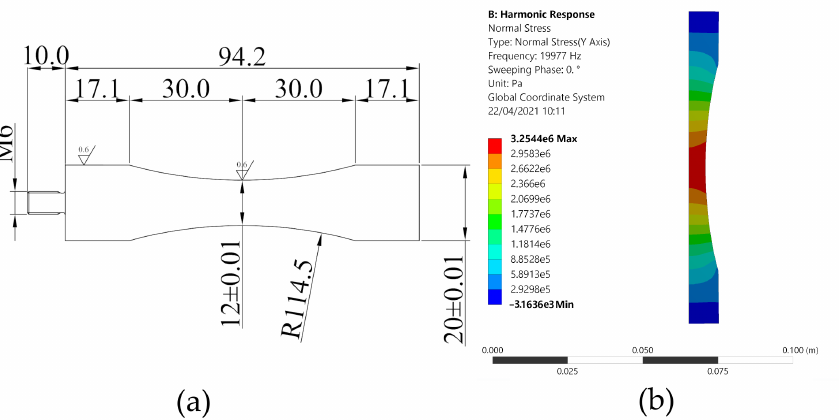
Figure 5. Specimen of 12 mm in diameter: ( a ) specimen geometry; ( b ) results of the numerical